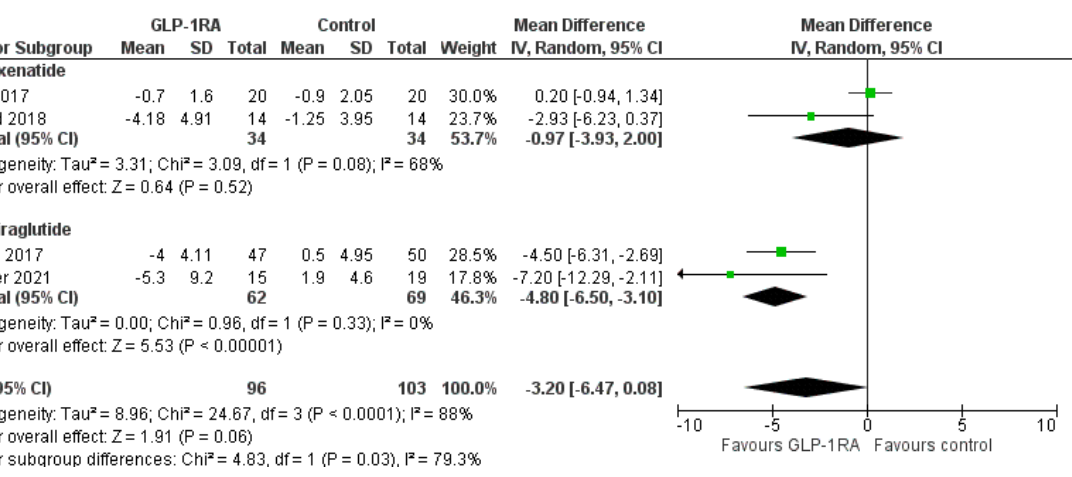
Figure 4. Effect of GLP-1RAs compared to controls on waist circumference among individuals treated with antipsychotic drugs. The diamond represents the overall effect estimate of the meta-analysis. The findings of each study are plotted as one square.